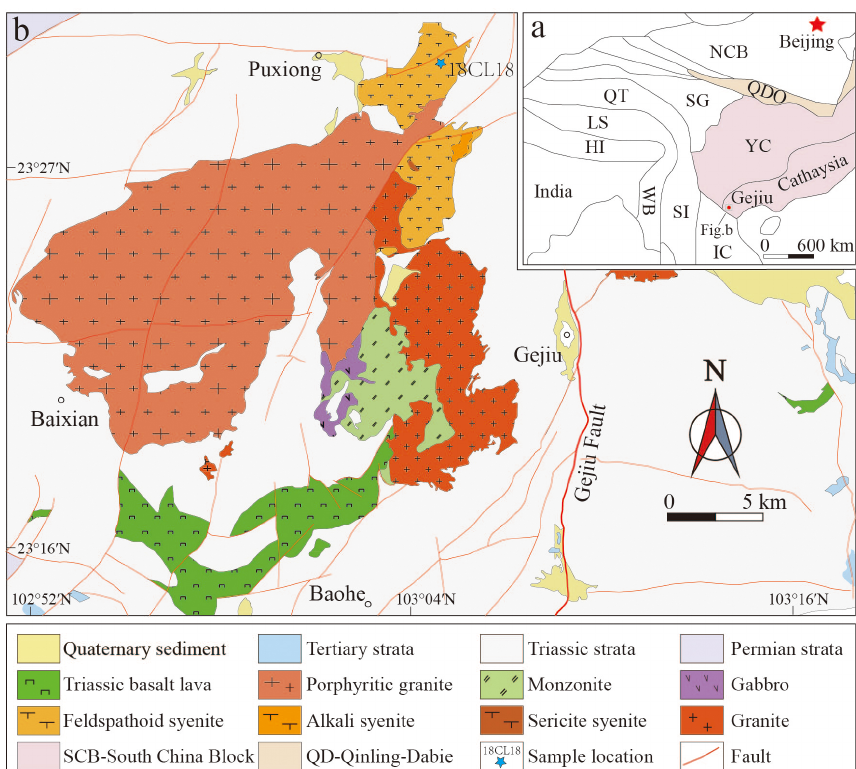
Figure 1. (a) Simplified tectonic map of eastern Asia (modified from Cheng et al., 2013); (b) geological map of the Gejiu, Yunnan (modified from Chen, 2019; Wang et al., 2019, 2021). NCB: North China Craton; QDO: Qinling–Dabie Orogen; IC: Indo-China Block; SI: Sibumasu Block; WB: West Burma; LS: Lhasa; QT: Qiangtang; SG: Songpan–Ganze Accretionary Complex; Hi: Himalaya.